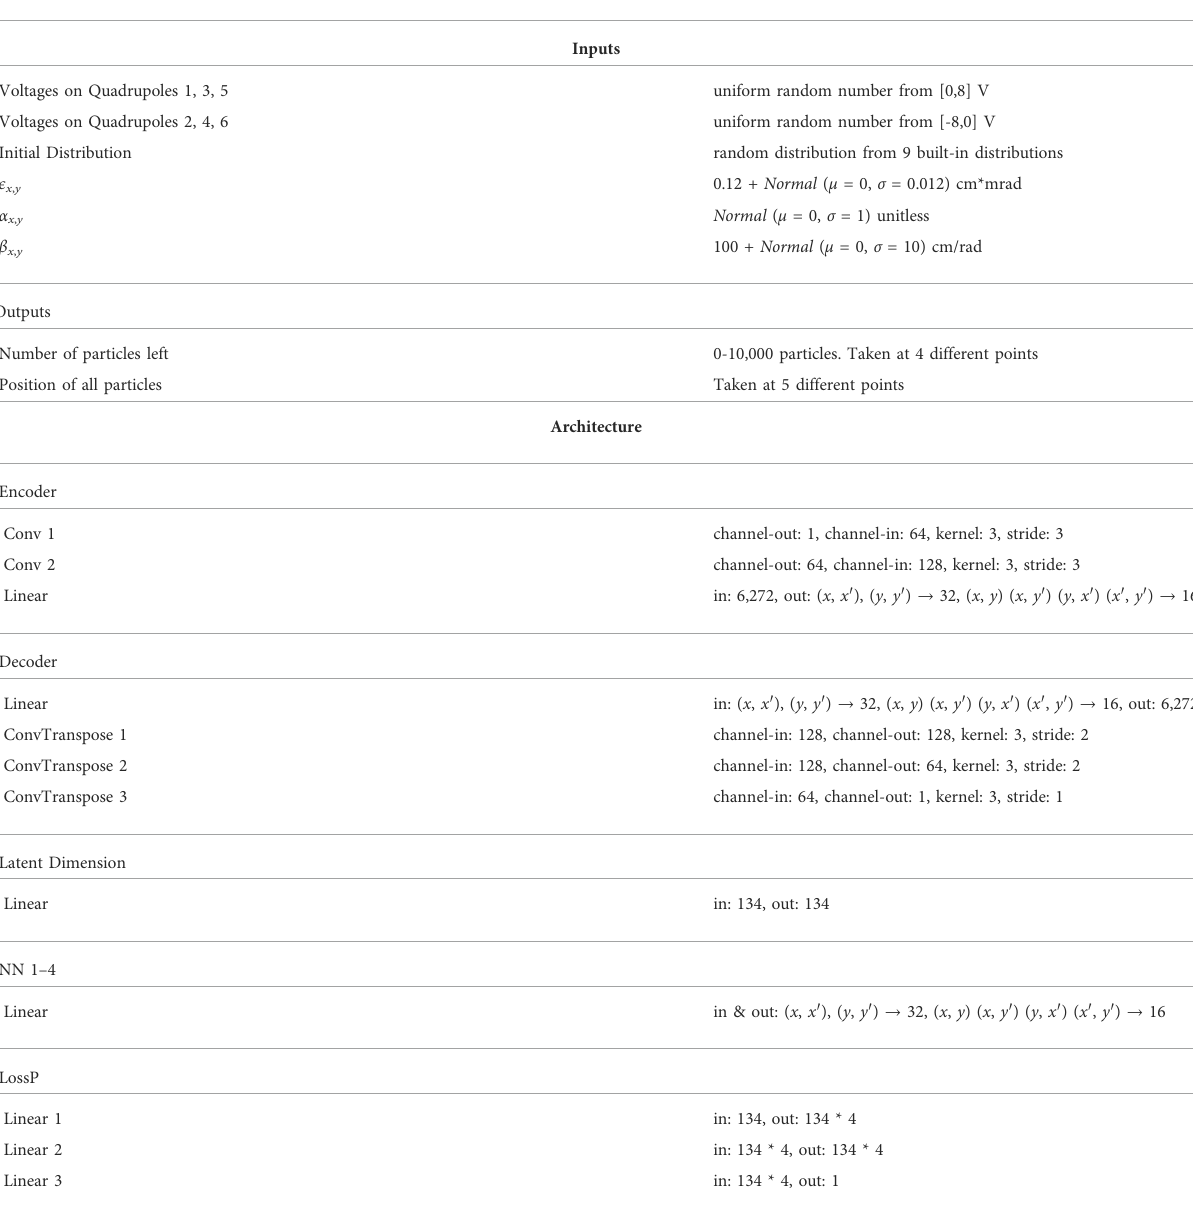
TABLE 1 Inputs: Parameter range used to generate a dataset of the initial beam distributions and quadrupole settings. Architecture: Description of some blocks used in the architecture. Each projection was given a separate encoder and decoder block where the latent dimension differ for the $( x , x 9 )$ and $( y , y 9 )$